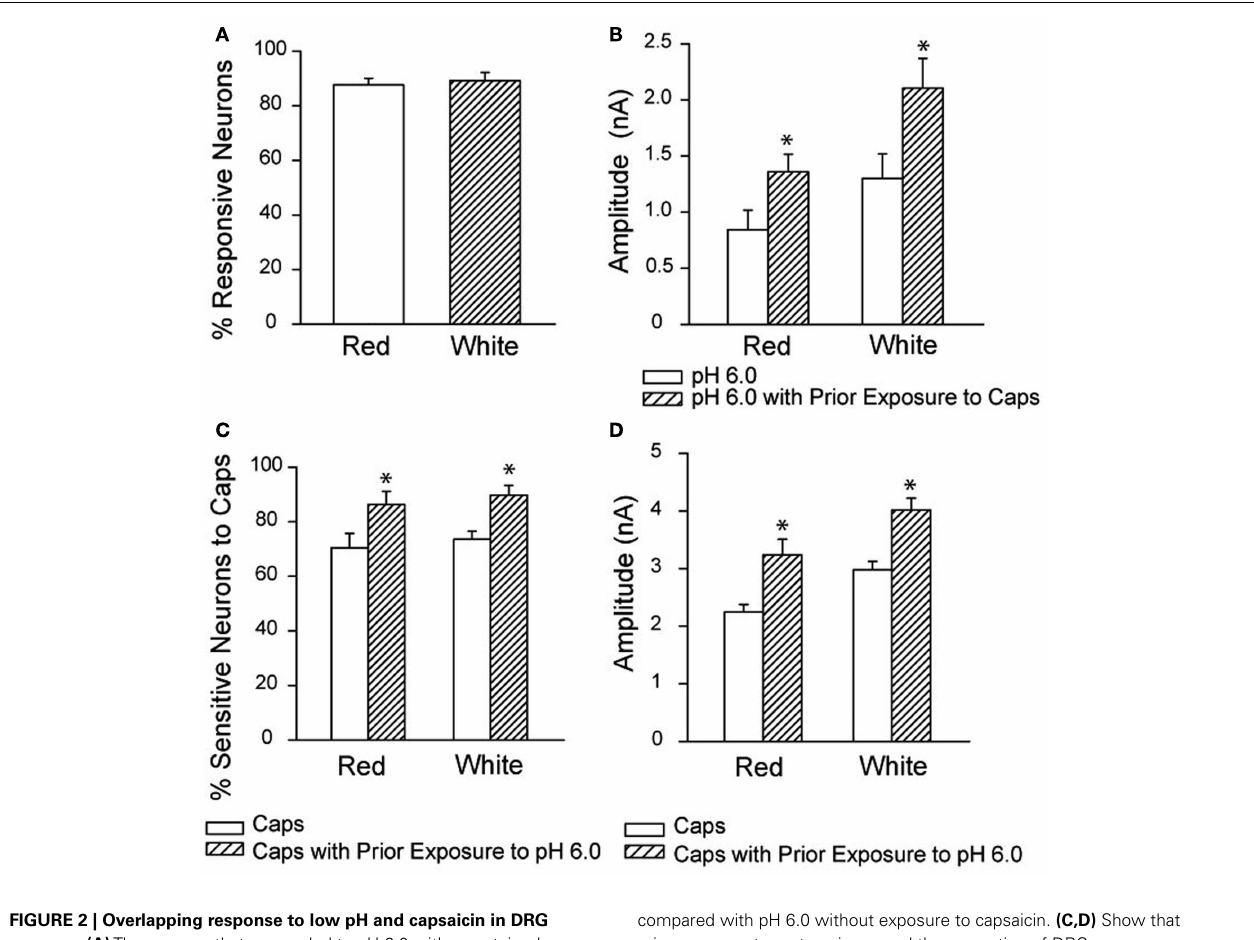
FIGURE 2 | Overlapping response to low pH and capsaicin in DRG neurons. (A) The neurons that responded to pH 6.0 with a sustained inward current also responded to capsaicin.The overlap was similar for DRG neurons innervating the red and white muscle. (B) Prior exposure to capsaicin increased the amplitude of the proton-evoked currents in DRG neurons innervating the red and white muscles. * P < 0.05